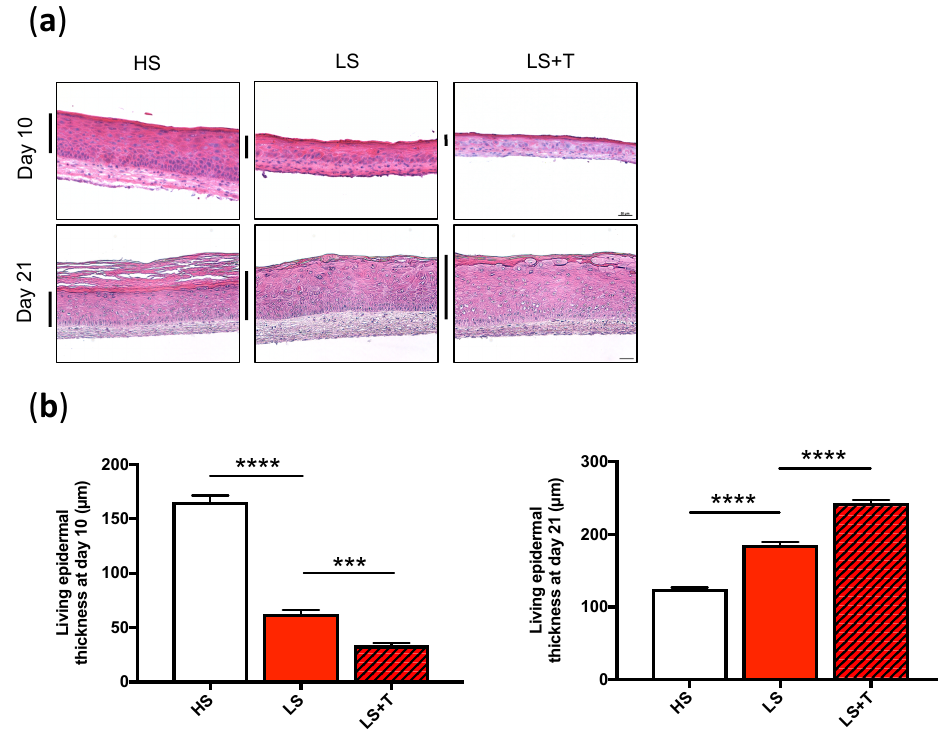
Figure 2. Migration of activated T cells within the dermis and the epidermis modified the turnover time of epidermal keratinocytes. ( a ) Histological analysis of reconstructed tissues at day 10 and day 21 of air-liquid culture. Black bars delimit the living epidermis of healthy (HS), lesional (LS), and lesional with T cells (LS + T) reconstructed skin. Scale bar = 50 µ m. ( b ) Quantification of the living epidermal thickness of healthy (HS), lesional (LS), and lesional with T cells (LS + T) reconstructed skin at day 10 (left panel) and 21 (right panel). The values are presented as mean ± SD ( n = 3). Significant differences (*** p < 0.001, **** p < 0.0001) are indicated by an asterisk.